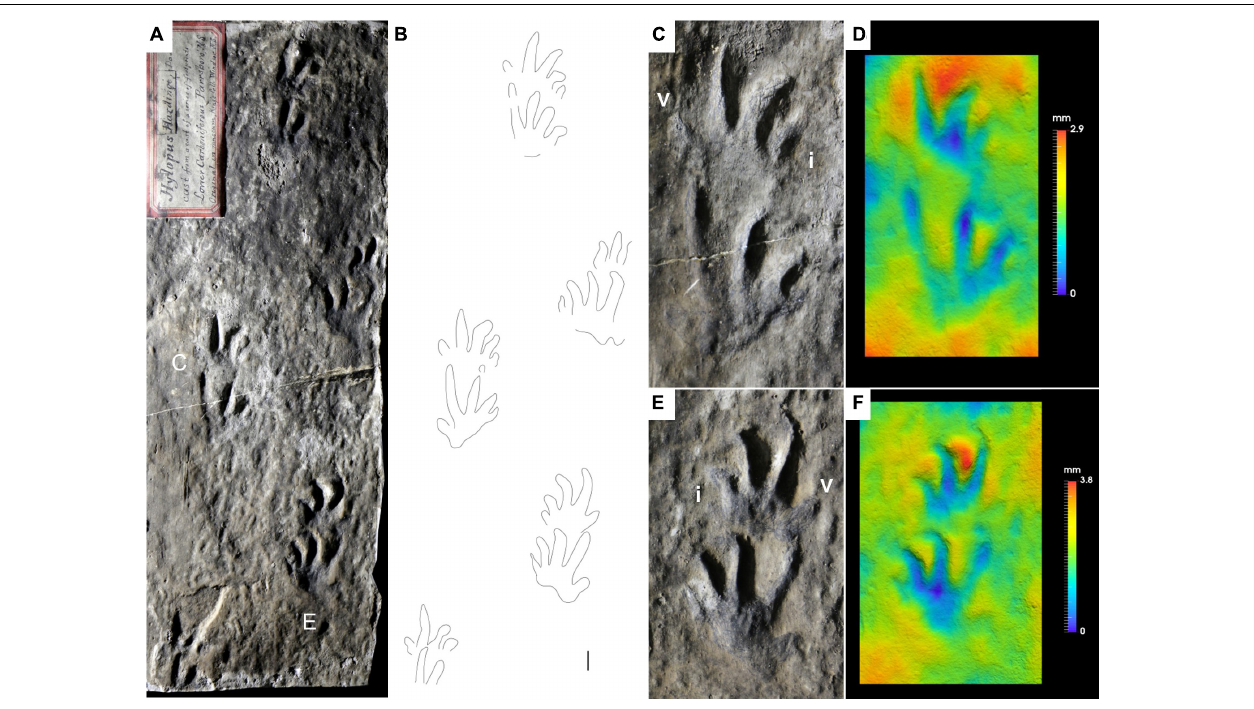
FIGURE 3 | Carboniferous anamniote reptiliomorph tracks, Hylopus hardingi . (A) NBMG 3060, “plastotype” of Hylopus hardingi , trackway, concave epirelief. Parrsboro Formation, Nova Scotia. (B) Interpretive drawing of (A) . (C) Enlargement of (A) . Right pes-manus couple. (D) False-color depth map of (C) . (E) Enlargement of (A) . Left pes-manus couple. (F) False-color depth map of (E) . Manual digits indicated by Roman numbers. Scale bar is 1 cm.